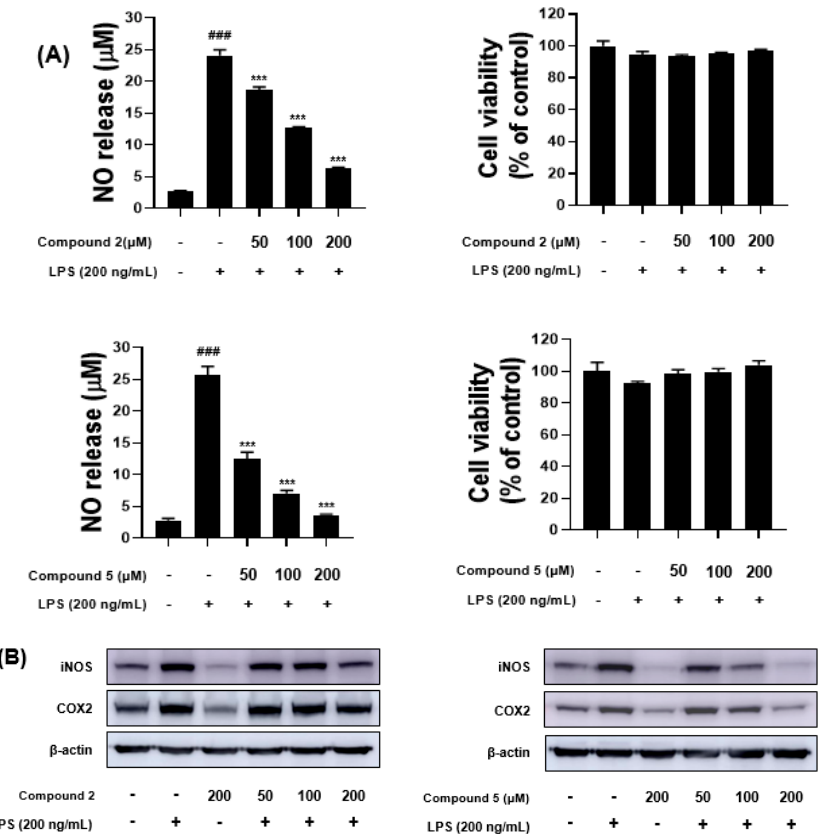
Figure 4. ( A ) The measurements of nitrite levels in the culture media were conducted using the Griess reaction. The release of NO was measured with indomethacin as a positive control (Figure S30). Cell viability was tested using the MTT (3-(4,5-dimetylthiazol-2-yl)-2,5-diphenyltetrazol bromide) assay. Results are shown as the percentage of control samples; ( B ) Inhibition of inducible nitric oxide synthase (iNOS) and cyclooxygenase-2 (COX-2) protein and mRNA expression by compounds 2 and 5 in lipopolysaccharide (LPS)-stimulated BV-2 cells. The data (B) is expressed as the relative signal intensity for two independent experiments. Values are the mean ± standard error. ### p < 0.001, vs. control group and *** p < 0.001 vs. LPS-treated